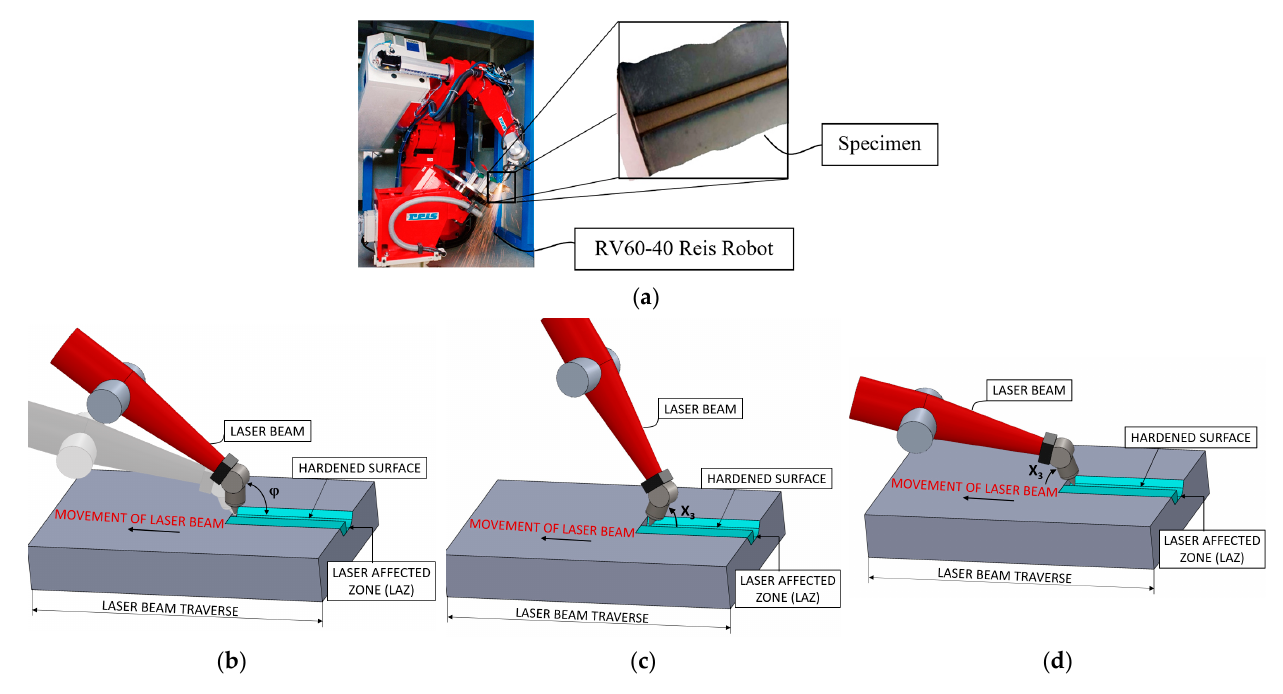
Figure 1. ( a ) RV60-40 robot and laser-hardened specimen. ( b ) Schematic view of the robot laser hardening process: ( b ) origin on the side of the hardened surface (impact angle φ , ranging from 0° to 180°); ( c ) horizontal component of the laser beam in agreement with the forward velocity of the laser beam (impact angles X 3 , ranging from 0° to 90°); ( d ) horizontal component of the laser beam in opposition to the forward velocity of the laser beam (impact angles X 3 , ranging from 0° to − 90°). Therefore, the angular value of φ = 150° according to the first notation is equivalent to the angular value of X 3 = − 30° according to the other notation and X 3 = 90° coincides with X 3 = − 90°. The second notation is useful to highlight whether the laser beam agrees with or is in opposition to the forward velocity and will be used below.